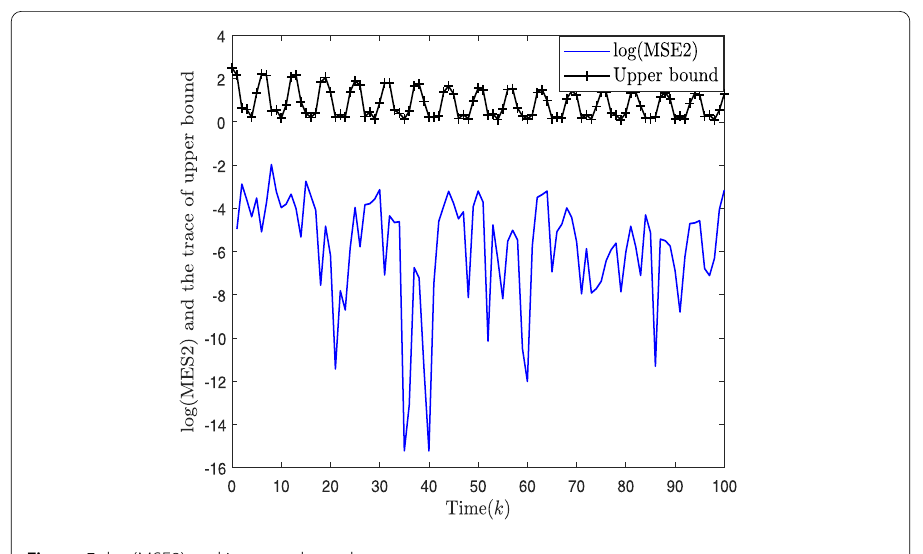
Figure 5 log(MSE2) and its upper bound